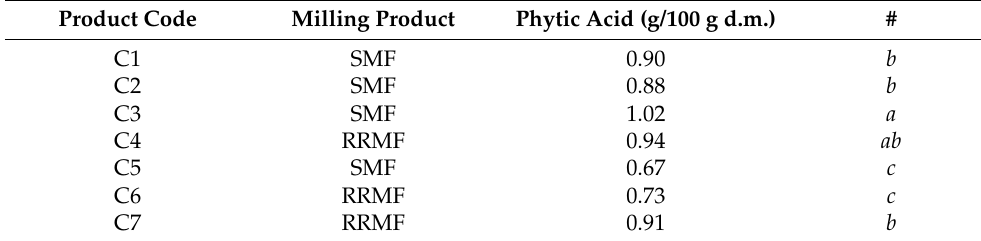
Table 2. Phytic acid in commercial soft wheat wholegrain